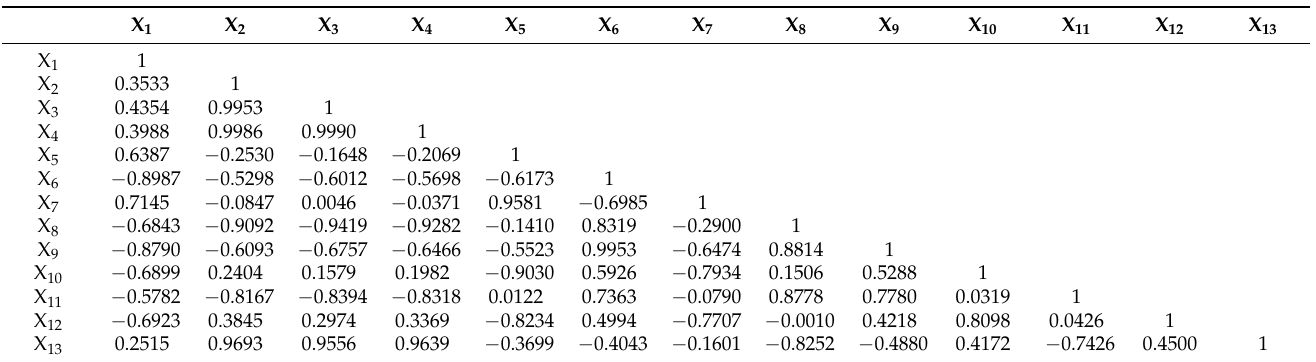
Table 1. Correlation coefficient matrix.